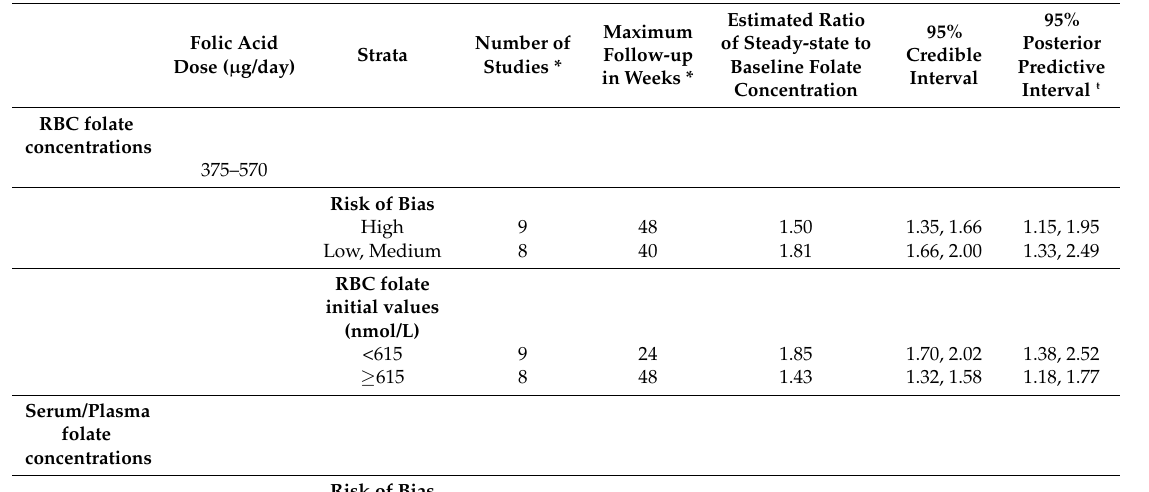
Table 2. Estimated ratio of steady-state to baseline red blood cell (RBC) and serum/plasma folate concentrations by initial folate concentration and risk of